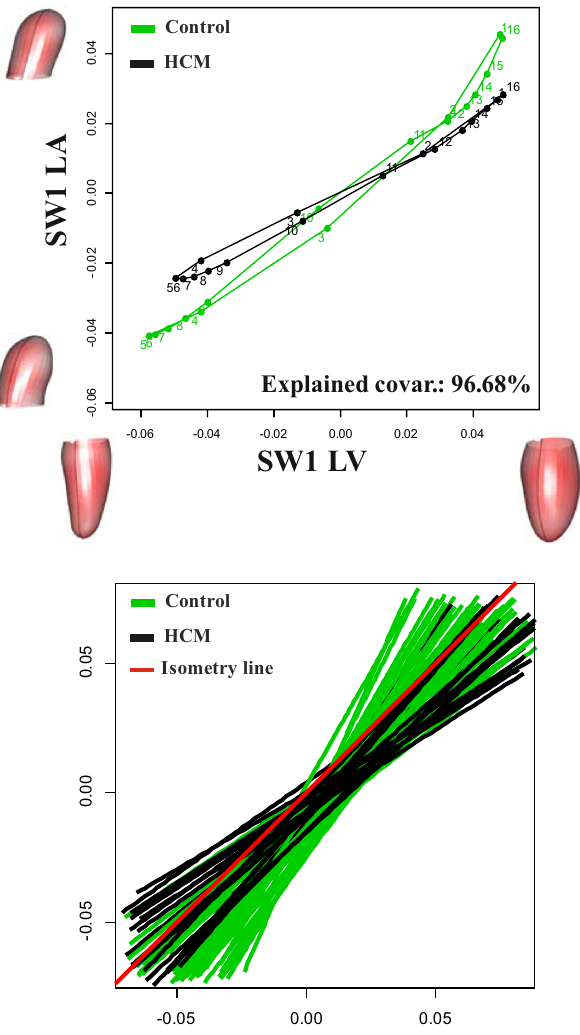
Figure 5. Shape covariation between LV and LA. Mean covariation trajectories (top) and MA regression fitting lines (bottom) are shown. Shapes correspond to extreme values (positive or negative) of Singular Warps axes.